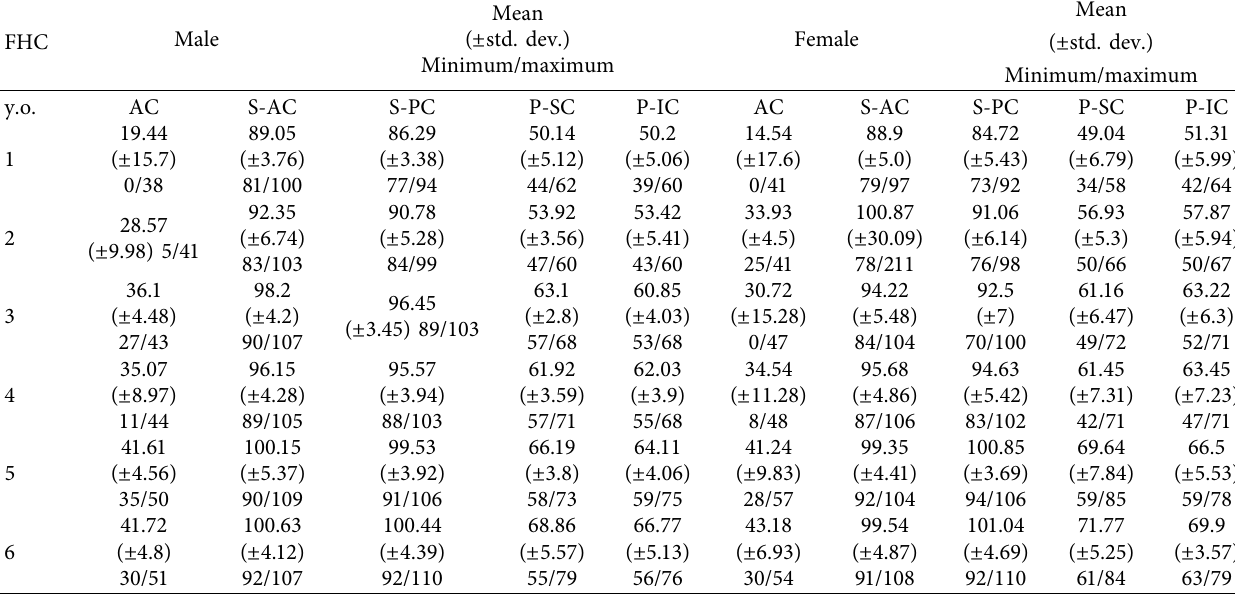
Table 1: Reference values of normal FH coverage by different acetabular regions in boys and girls aged 1–6y.o.